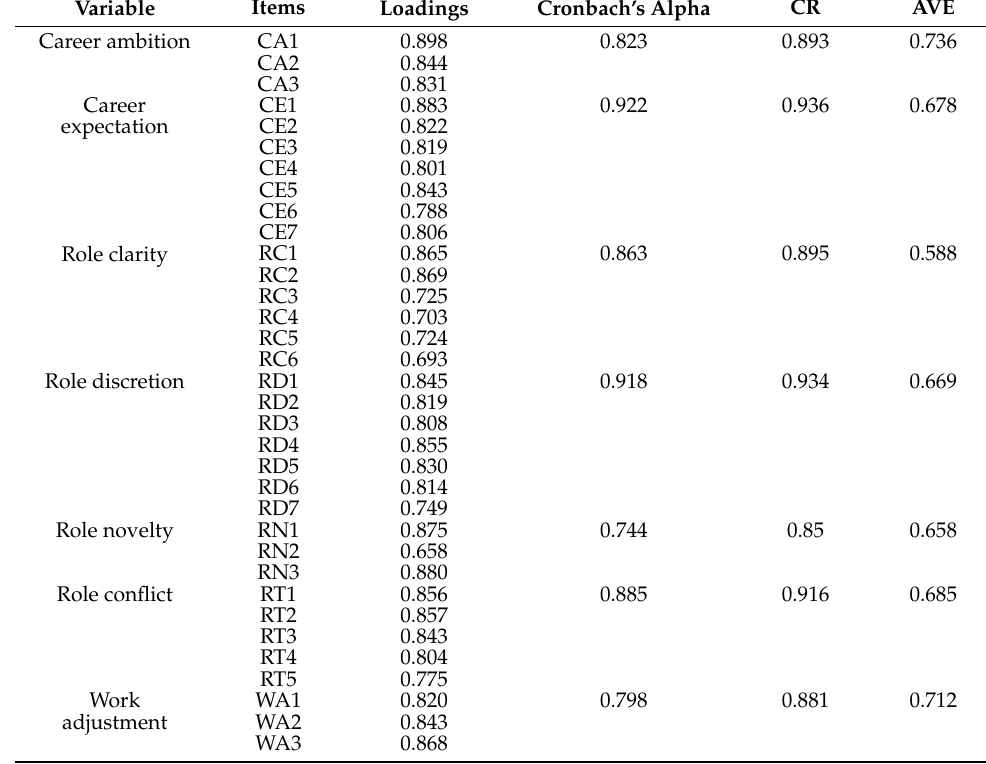
Table 3. Convergent